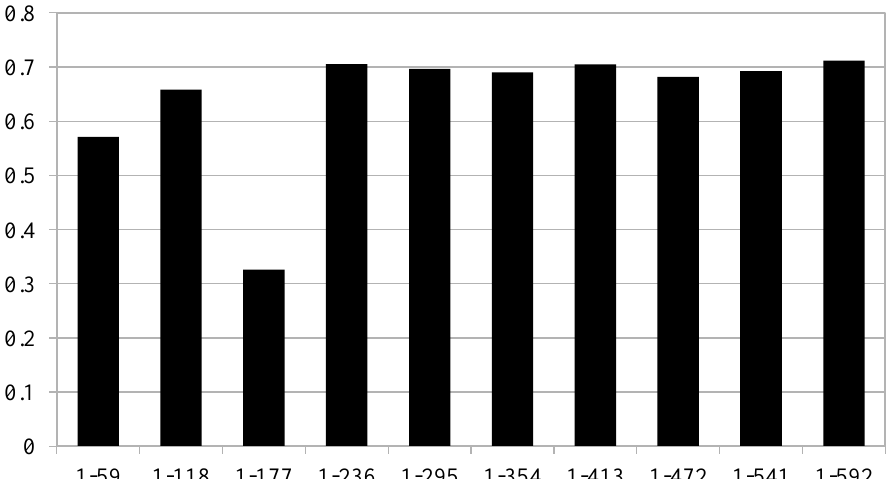
Figure 2. R 2 Between PCA and capital city distances for subsets of increasing numbers of